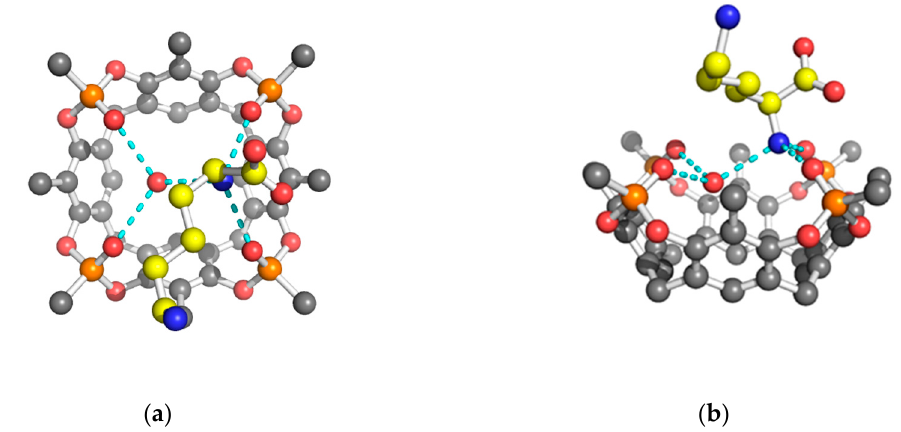
Figure 4. Orthogonal views of the H-bond interactions (cyan dashed lines) between the α -ammonium group of Lys amino acid (yellow carbons) and Tiiii (gray carbons) mediated by a water molecule (red sphere). Hydrogen atoms have been omitted for clarity. ( a ) top view ( b ) side view